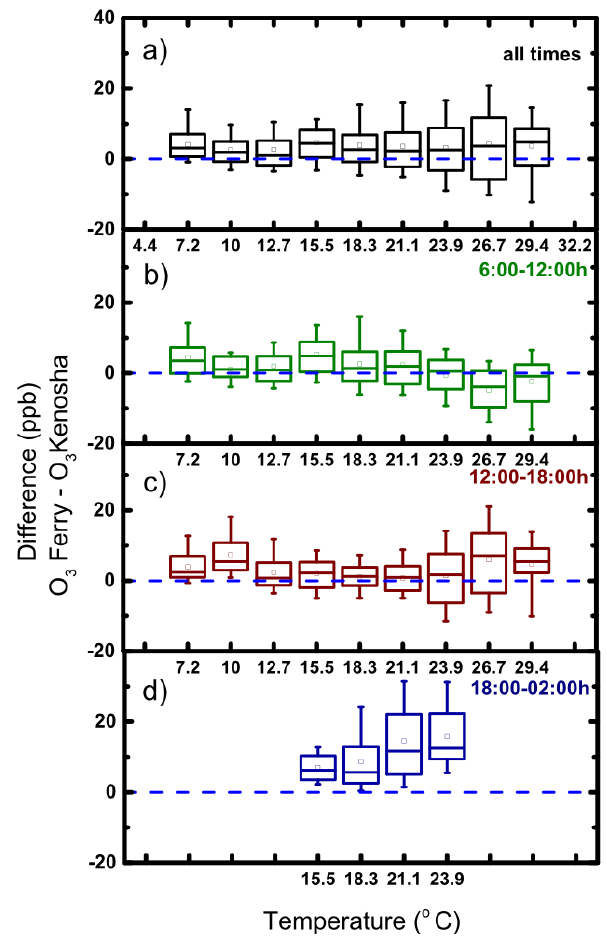
Figure 5. Difference in O 3 observations between platforms with respect to temperature ( ◦ C) measured at the shoreline for (a) all times, (b) morning (06:00–12:00CDT), (c) early afternoon (12:00– 16:00CDT) and (d) late afternoon/evening (16:00–02:00h). Box plots show mean ( (cid:3) ), median (centerline), 25–75% (box) and 10– 90% (whiskers). Each box represents a minimum of 15